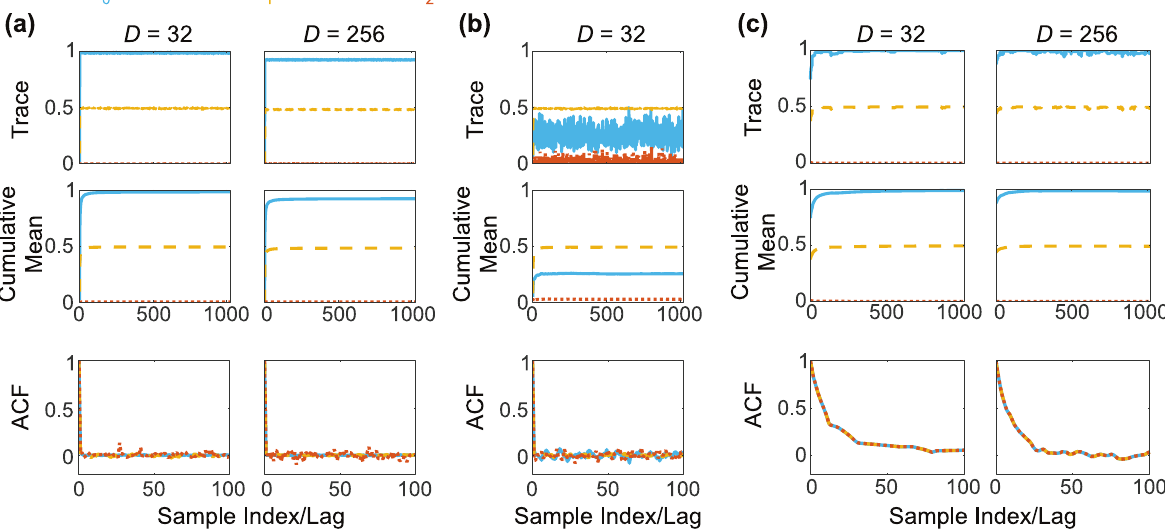
Fig. 8 Example MCMC chains. a Pseudo-likelihood of Eq. (10). b Pseudo-likelihood of Eq. (11). c Likelihood of Eq. (13). Three metrics are plotted separately for each observable λ n . The chains in a are examples from Fig. 4 of the main text, those in b from Fig. 5, and those in c from Fig. 6.